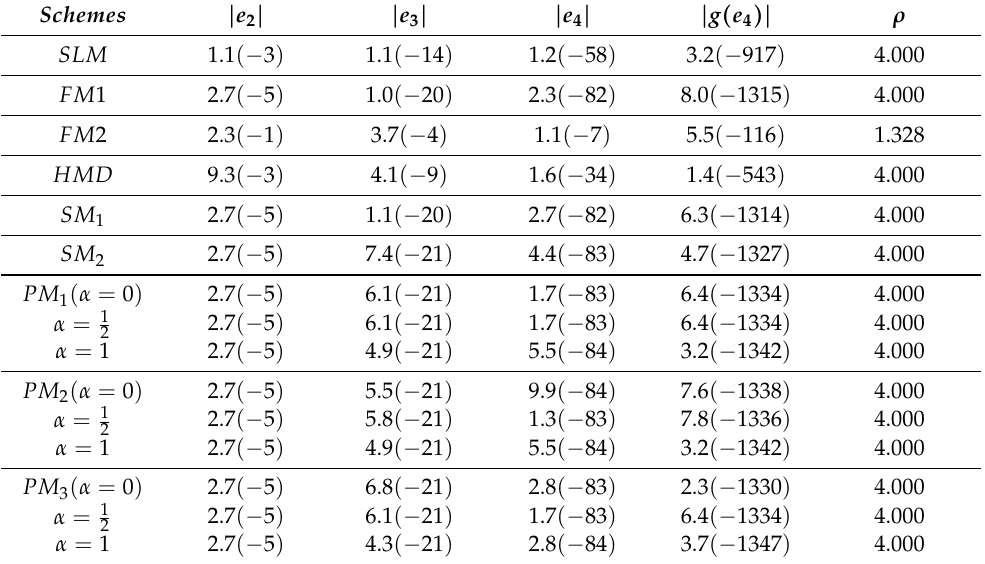
Table 4. Numerical results of Example